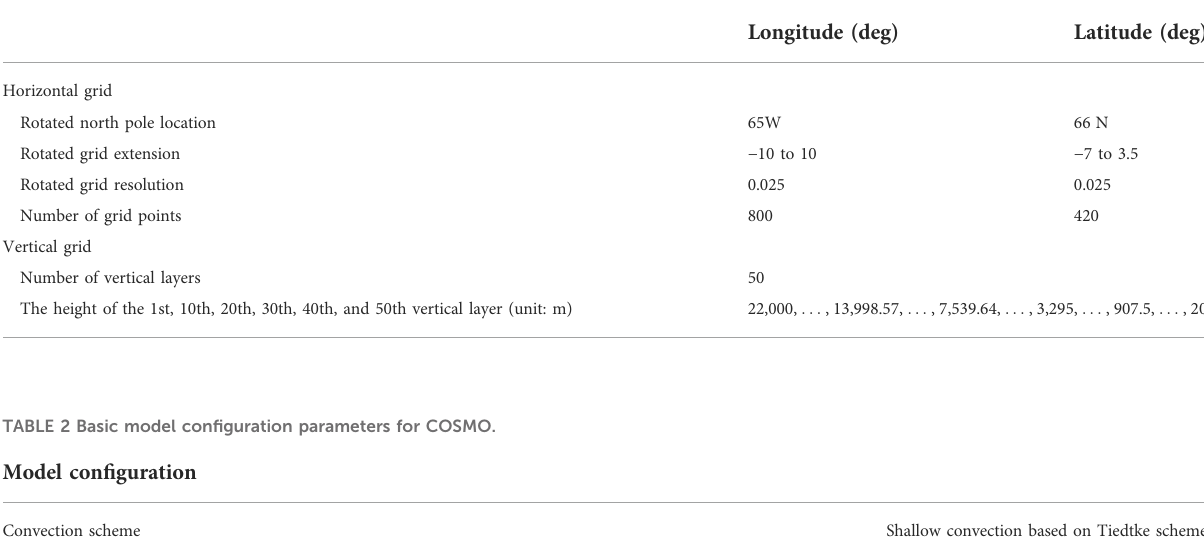
TABLE 1 Grid speci fi cations of the COSMO model.